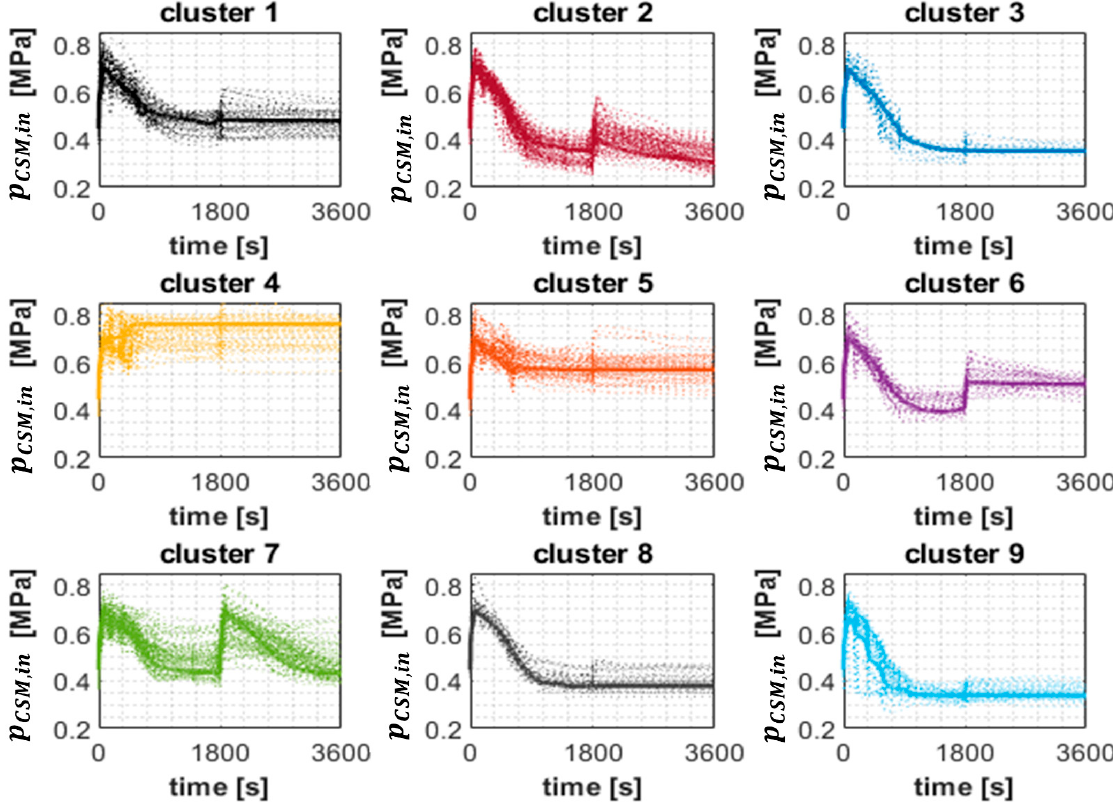
Figure A2. Nine clusters of p CSM , in transient scenarios generated by POD-based Kriging